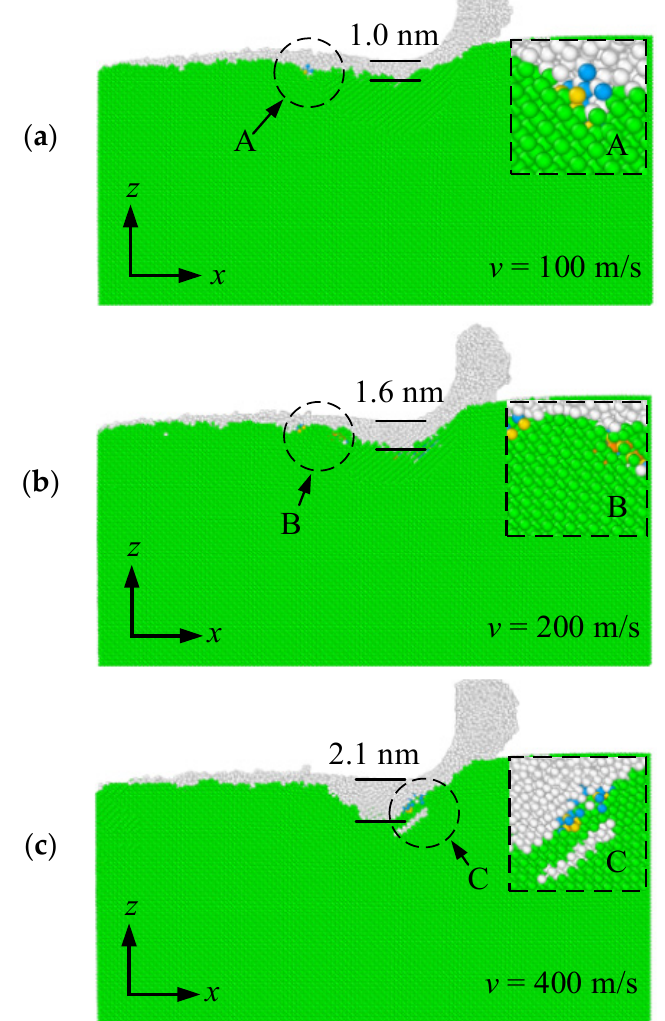
Figure 5. The effect of cutting speed on the subsurface damage at different cutting speed of ( a ) 100, ( b ) 200, and ( c ) 400